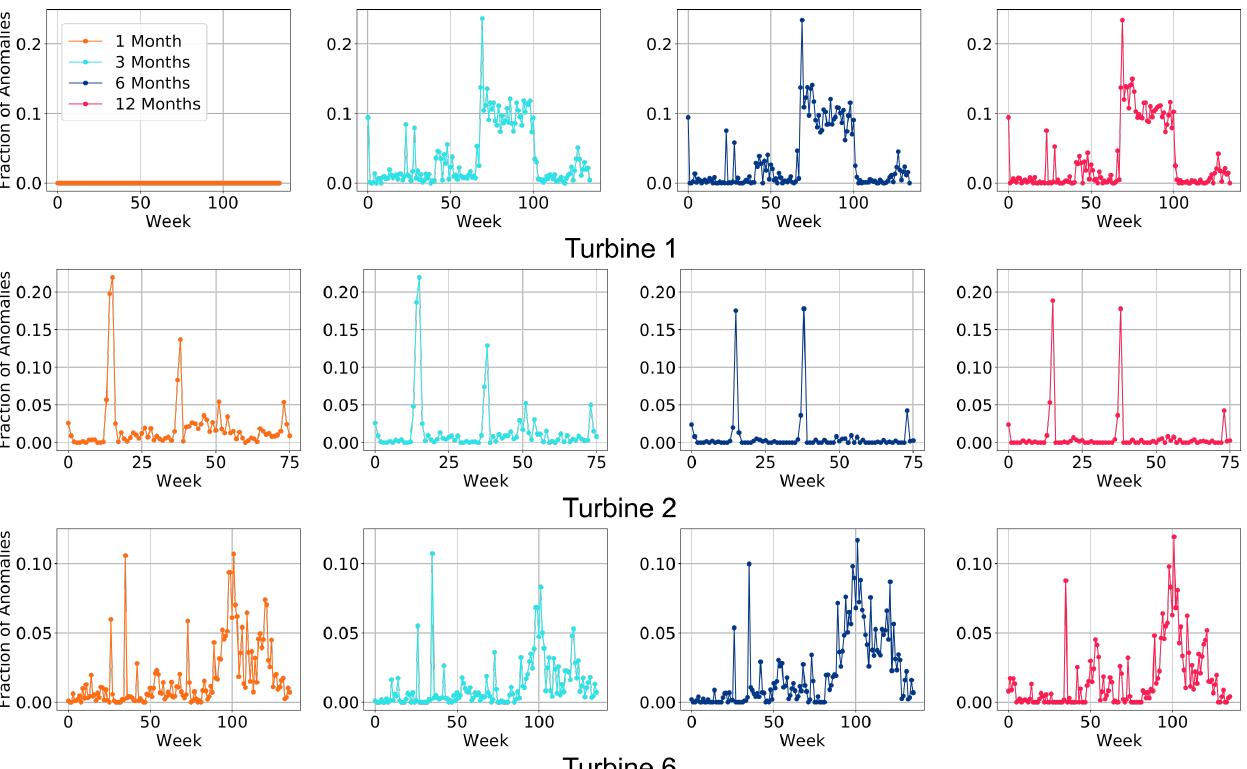
Figure 5. Comparison of training data length for turbines 1 and 2. Results taken from models trained on 1, 3, 6, and 12 months of data